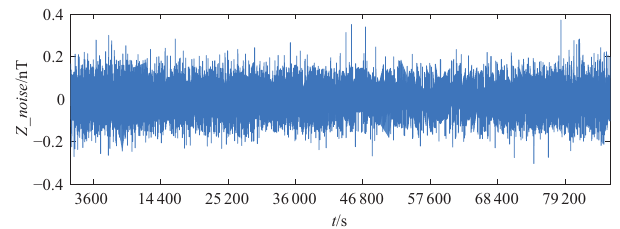
Figure 4. Estimated noise of the Z component.